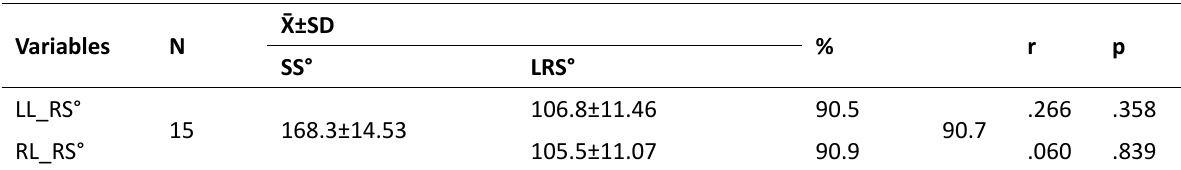
Table 1. Functional active flexibility “Side Split (SS°)” during the execution of the techniques requires mobility “Leg Raise Sideward (LRS°)”